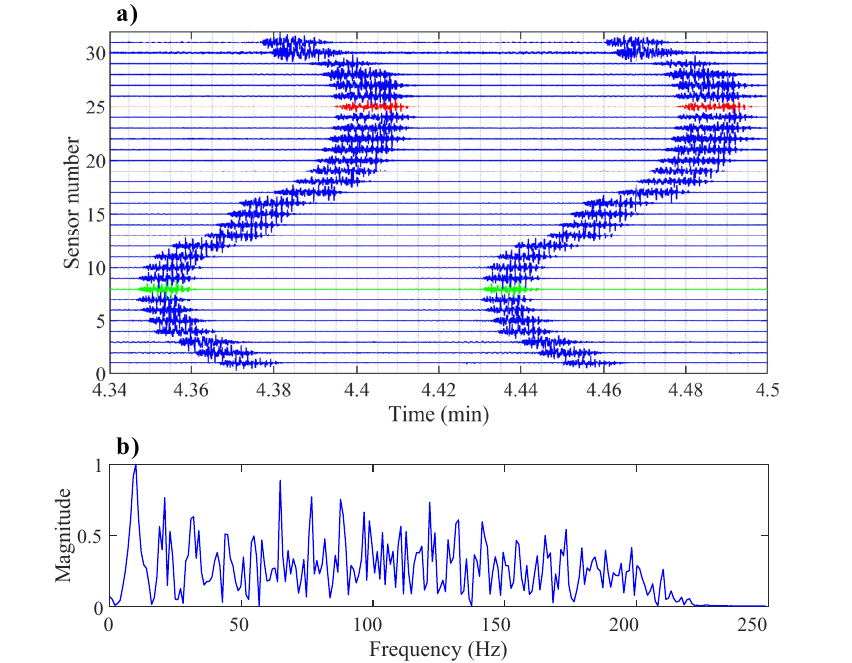
Figure 3. ( a ) arrival analysis on Event A. The green waveform represents the earliest arrival and the red waveform represents the latest arrival. The amplitudes of the signals are normalized by the maximum of each waveform; ( b ) the spectrum of Event A. Note that the magnitude is normalized to the maximum